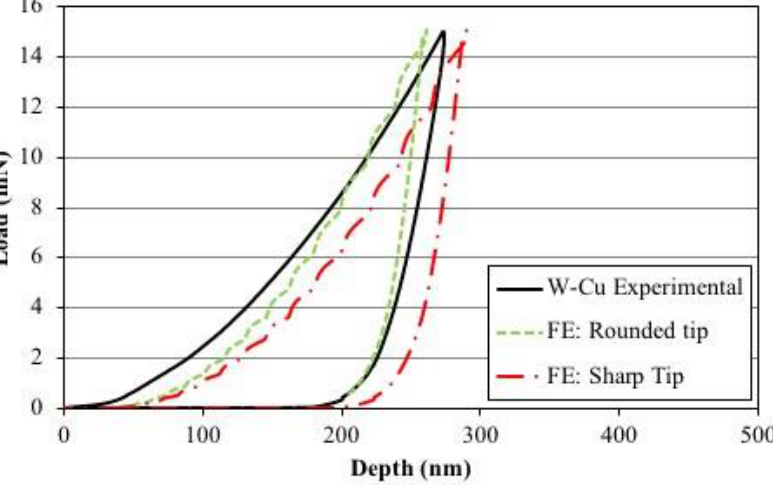
Figure 10. Comparison of the experimental result of a W-Cu specimen with the numerical results of a fully dense model utilizing sharp and rounded Berkovich indenters.